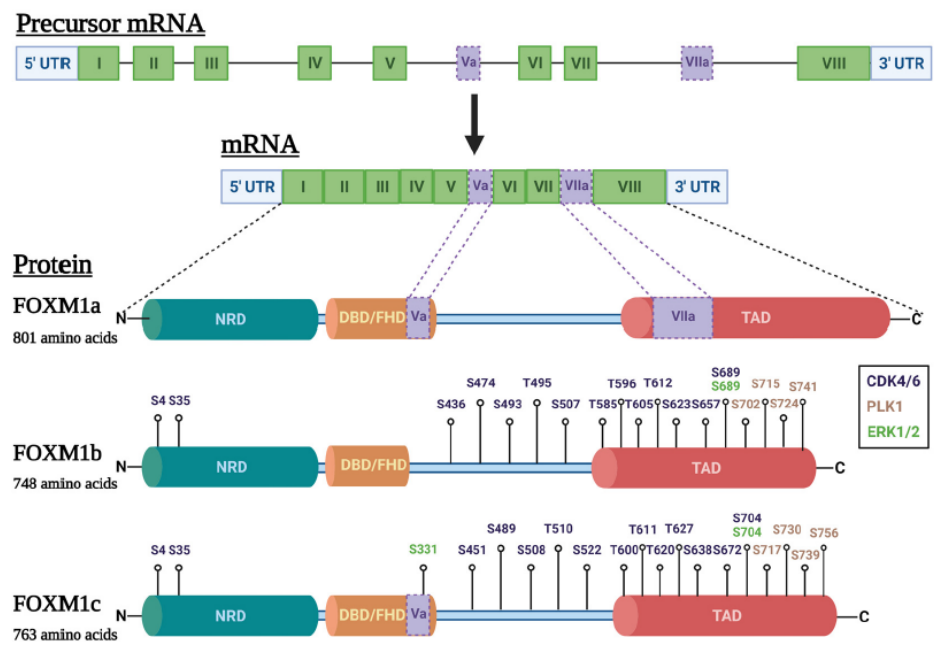
Figure 2. FOXM1 isoforms and phosphorylation sites in ovarian cancer. Top: FOXM1 precursor mRNA (with introns and exons indicated) followed by FOXM1 mRNA structure (exons only). Exons shared by all FOXM1 isoforms are shown in green while alternative exons are shown in light purple. Bottom: Diagram of protein structure of the three major FOXM1 isoforms: (1) FOXM1a, which contains alternative exons Va and VIIa; (2) FOXM1b, which contains no alternative exons; and (3) FOXM1c, which contains alternative exon Va. The three major protein domains are indicated: N-terminal repressor domain (NRD, teal); DNA binding/forkhead domain (DBD/FHD, orange); and transactivation domain (TAD, red). The protein regions corresponding to the alternative exons Va and VIIa are shown in light purple. FOXM1 residues reported to be phosphorylated by three kinases important in ovarian cancer, CDK4/6 (dark blue), PLK1 (tan), and ERK1/2 (green), are indicated. Figure created with BioRender.com.